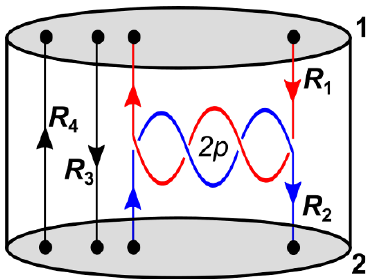
Figure 12 . The quantum state Ψ on two S 2 boundaries labeled by 1 and 2. The Wilson lines 3 (cid:30) | and R are braided even number of carrying rep R 1 2